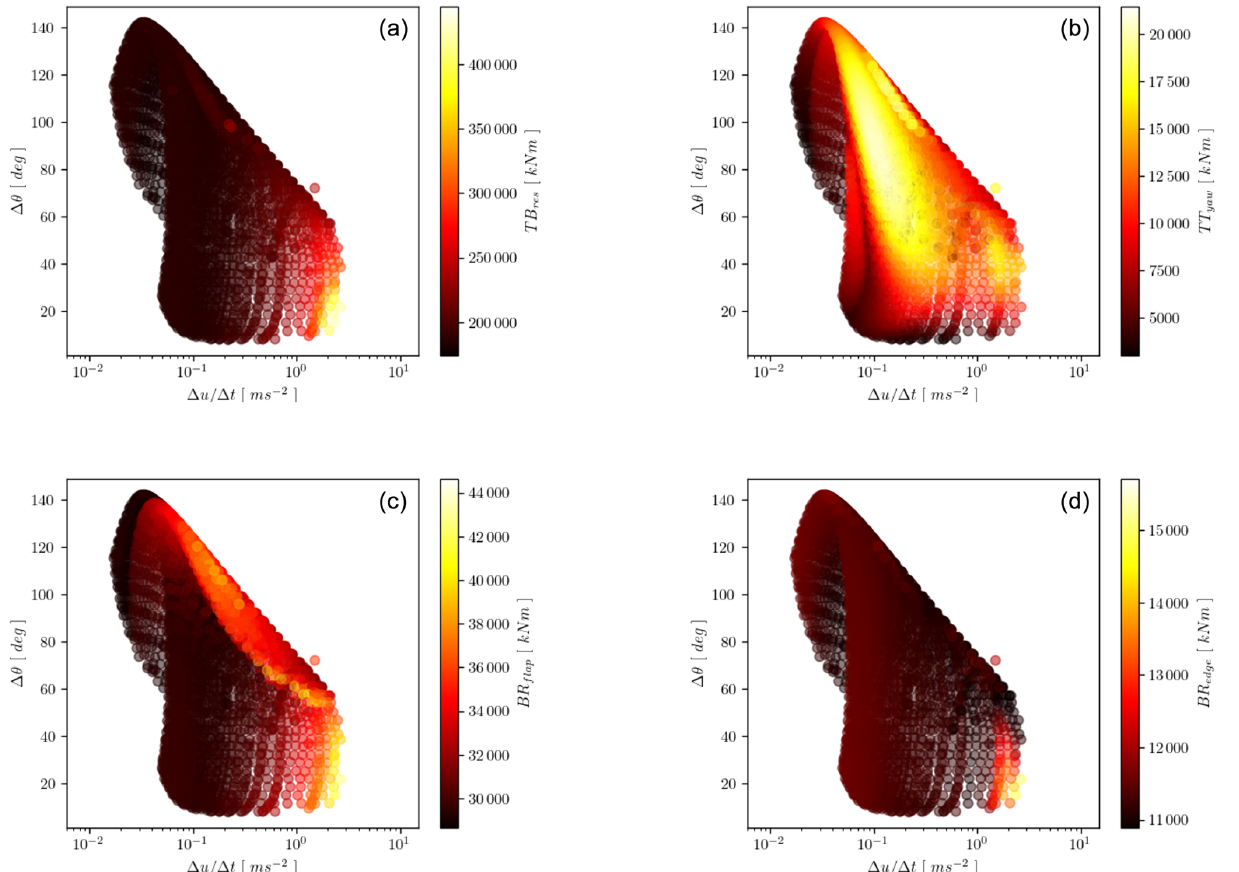
Figure 6. Simulation results with yaw control. The absolute maximum responses are shown with the color scale on the 2D gust variable domain of acceleration and direction change. Notice the IEC ECD gust in all panels is the single outlier. The relevant channel is indicated on the right of the color bar legend: (a) tower-bottom resultant moment, (b) tower-top yawing moment, (c) blade root flap moment, and (d) blade root edge moment.